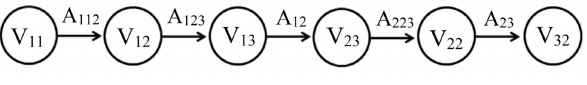
Figure 9. Zigzag